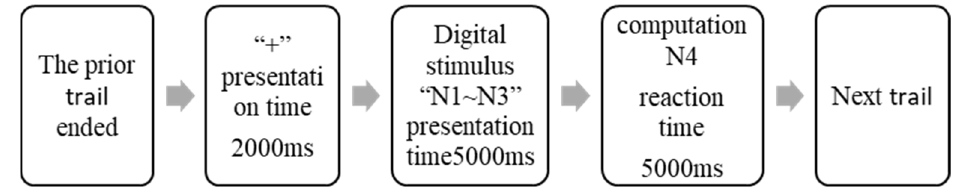
Figure 3. Single trail flow chart of CPT task.